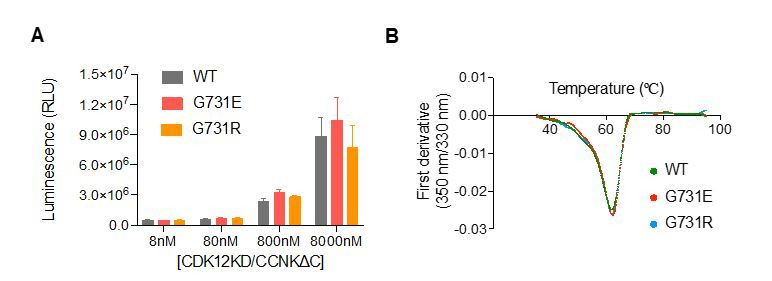
CDK12G731E/R mutations do not affect CDK12 kinase activity or protein stability.(A) CDK12KD/CCNKΔC (WT or G731E/R mutants) kinase activity was perform in 10μL reaction volume containing 45nM substrate (GST-CTD) and a reaction buffer of 20mM HEPES, pH7.9, 20mM MgCl2, 2mM DTT, 1mM ATP. The reaction was initiated by adding 8nM, 80nM, 800nM, or 8μM CDK12KD/CCNKΔC (WT or G731E/R mutants) and incubated at 30°C for 1hour followed by the addition of 10μL ADP-GloTM Reagent (Promega, V6930) to terminate kinase reaction and remove unreacted ATP. After incubation at room temperature for 40 minutes, the mixtures were transferred from PCR tubes to a 384-well plate and mixed with 20μL Kinase Detection Reagent (Promega, V6930). The mixtures were allowed to sit at room temperature for 40 minutes before reading luminescence by EnVision multimode plate reader (Perkin Elmer). Error bars represent SD from three replicates. (B) Thermal denaturation of CDK12KD/CCNKΔC (WT or G731E/R mutants) measured by nano DSF.